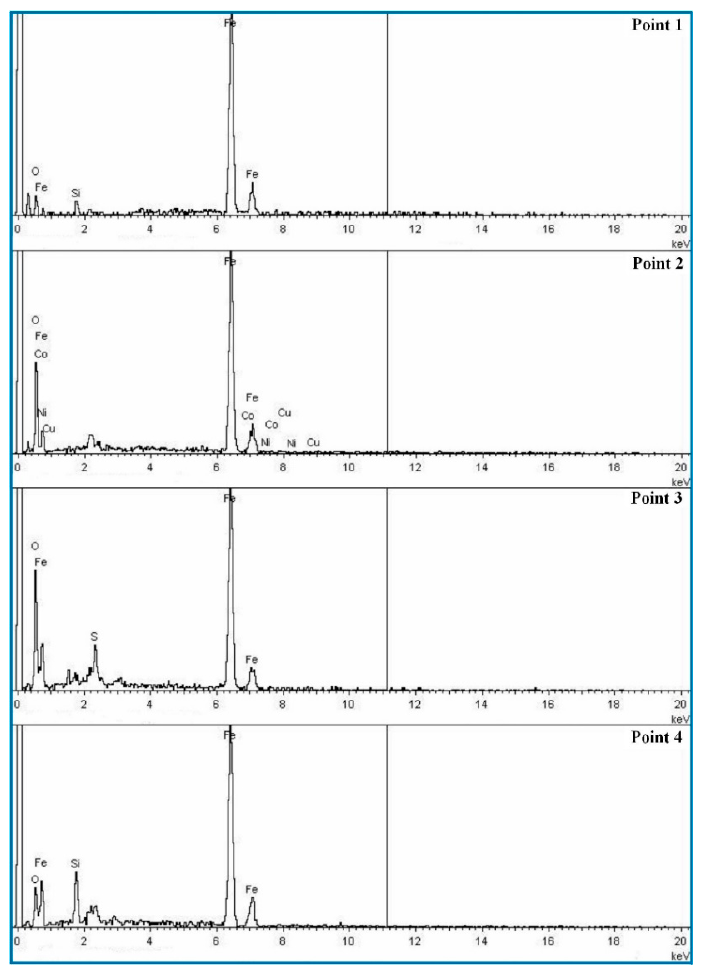
Figure 7. EDS spectra of coal-based reduction samples for the reduction time of 60 min.